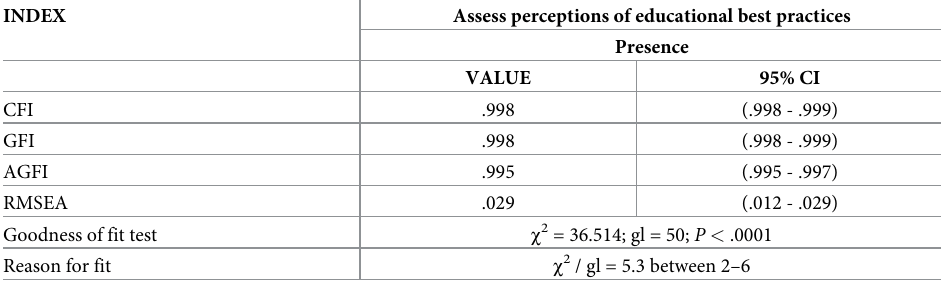
Table 5. Indices of goodness of fit of the exploratory bifactor model of Presence scale.